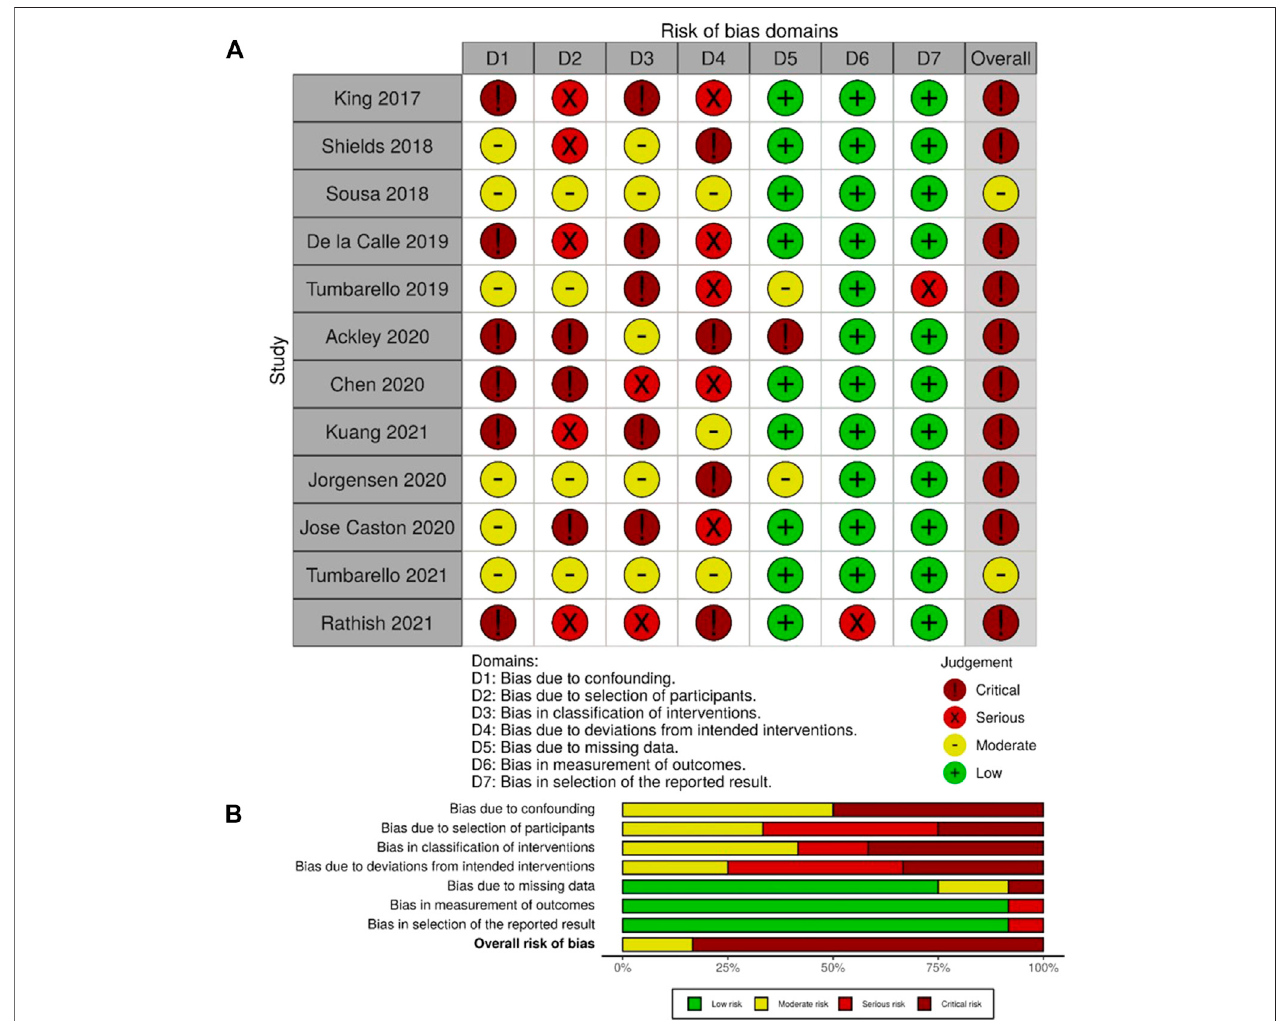
FIGURE 2 | Risk of bias for each domain and each study in seven